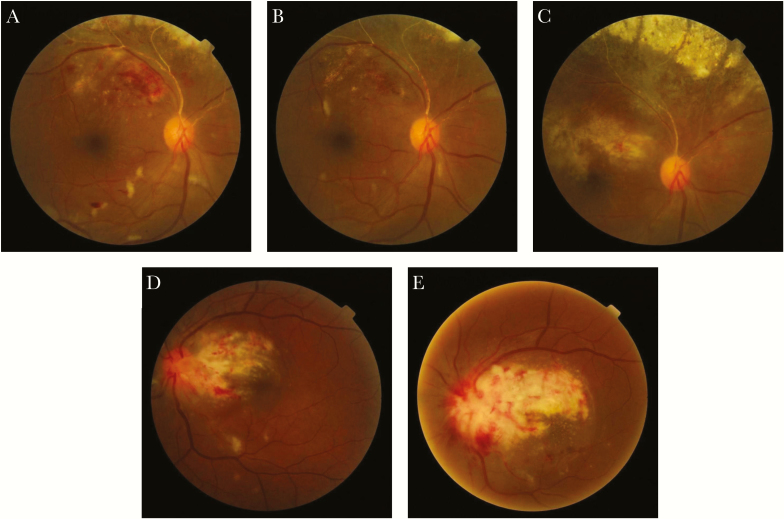
Fundus photography of patients 2 and 5. (A) Patient 2 at diagnosis. (B) Patient 2 after 6 injections. (C) Patient 2 after stopping treatment. (D) Patient 5 at diagnosis. (E) Patient 5 after 3 injections.